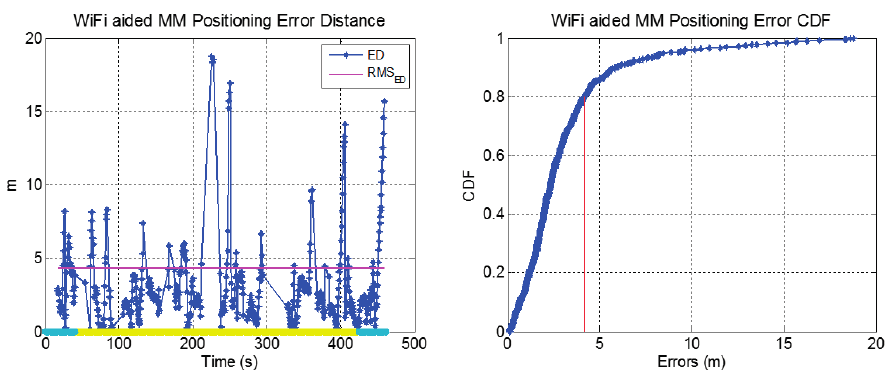
Figure 13. WiFi-aided MM position errors at EEEL.